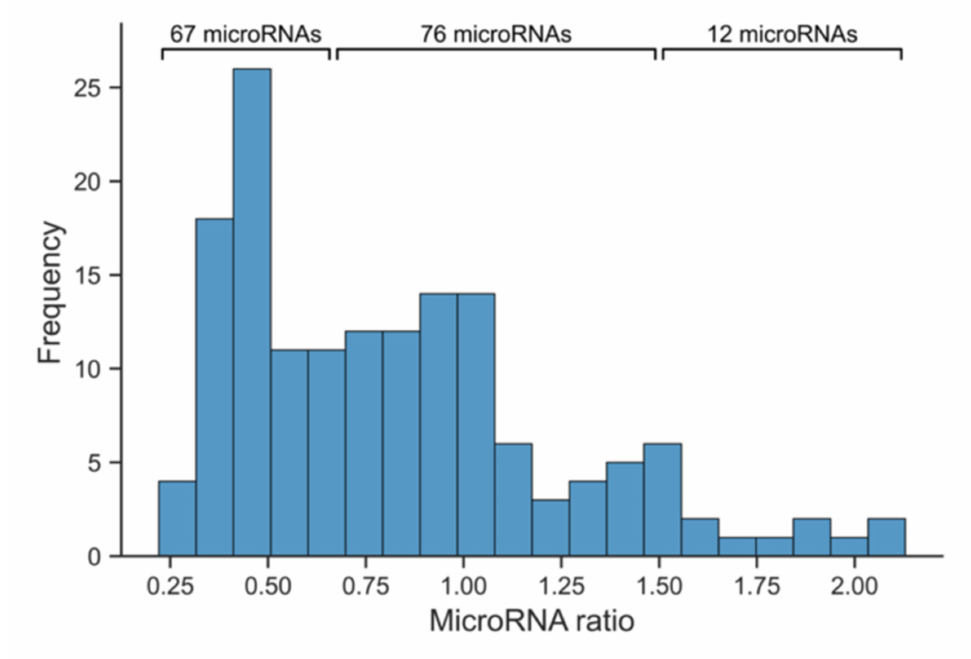
Figure 2. Distribution of ratios of reliably detectable microRNAs in marathon runners. The dis- tribution of ratios of reliably detectable microRNAs in marathon runners ranges from 0.22 to 2.13. According to the ratios of these 155 microRNAs, 12 microRNAs demonstrate upregulation (cut-off value 1.5), while 67 microRNAs present downregulation (cut-off value 1/1.5) in the high cTnT co- hort compared to the low cTnT cohort. In contrast, 76 microRNAs show no relevant differences of marathon-induced dysregulations between both cohorts. Ratios were calculated based on microRNA expressions from next-generation sequencing (see material and methods). Abbreviation: cTnT, cardiac troponin